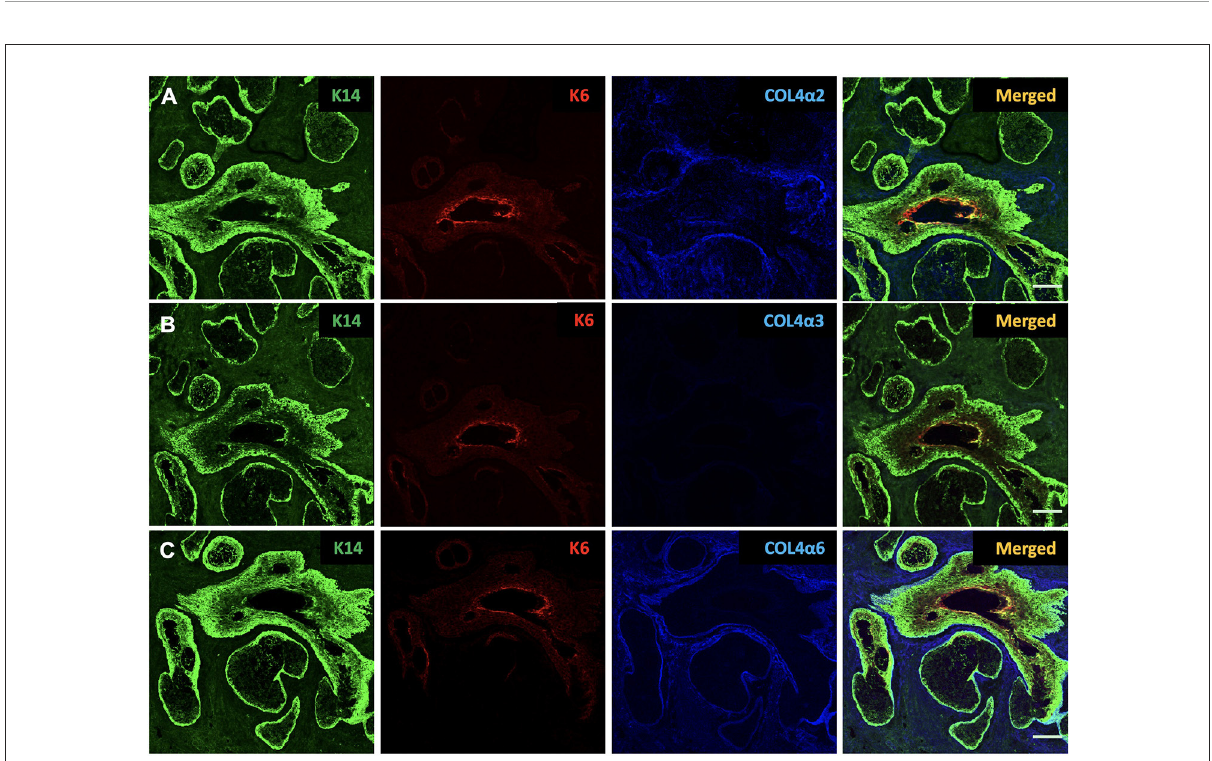
FIGURE1 Identification of cytokeratin 14 (K14, green), cytokeratin 6 (K6, red), collagen IV α 2 (COL4 α 2, blue), collagen IV α 3 (COL4 α 3, blue) and collagen IV α 6 (COL4 α 6, blue) in the human Meibomian gland (MG). K14 is present in both ductal and acinar epithelial cells, whereas K6 expression is restricted to ductal cells. Human MG tissues stain positive for COL4 α 2 (A) and COL4 α 6 (C) , but negative for COL4 α 3 (B) . Scale bar = 100 µ